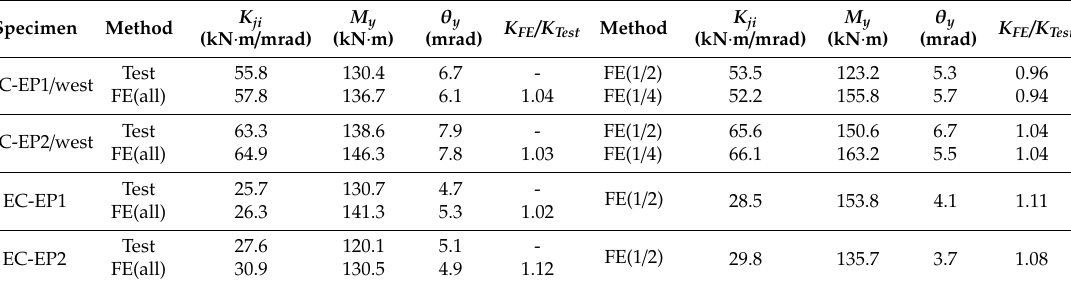
Table 8. Comparison of the FE analysis and test